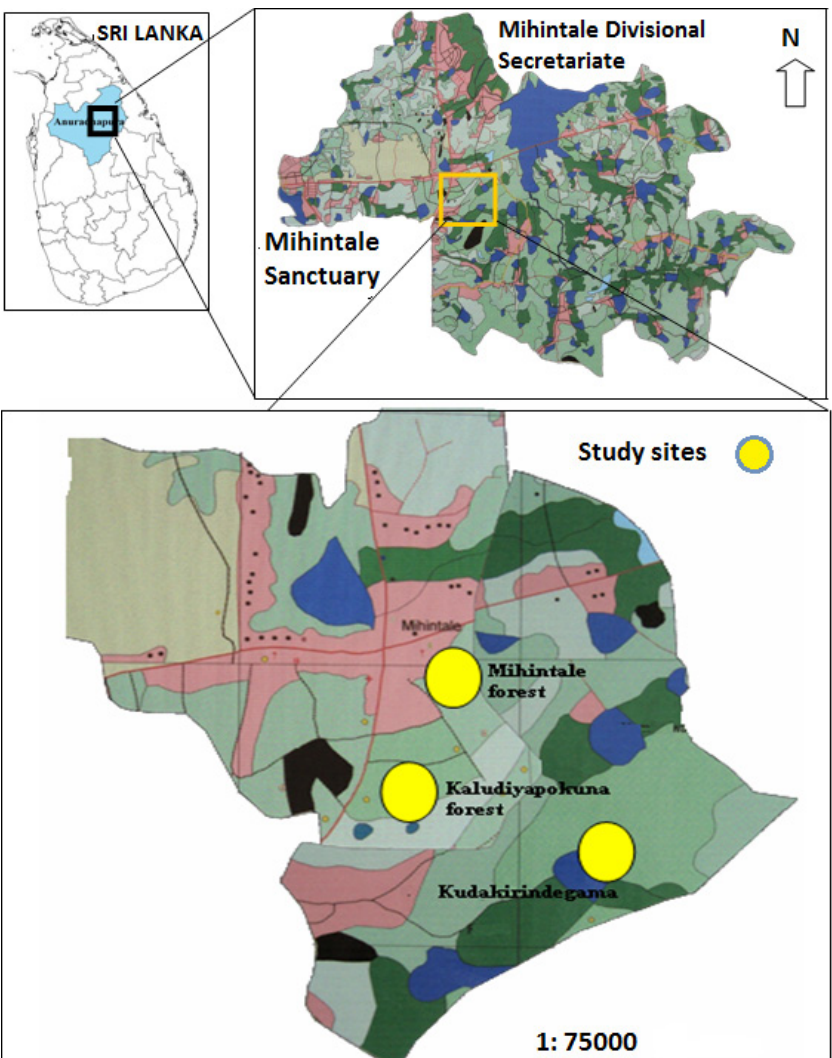
Figure 1. Sampling sites of selected habitats within the Mihintale